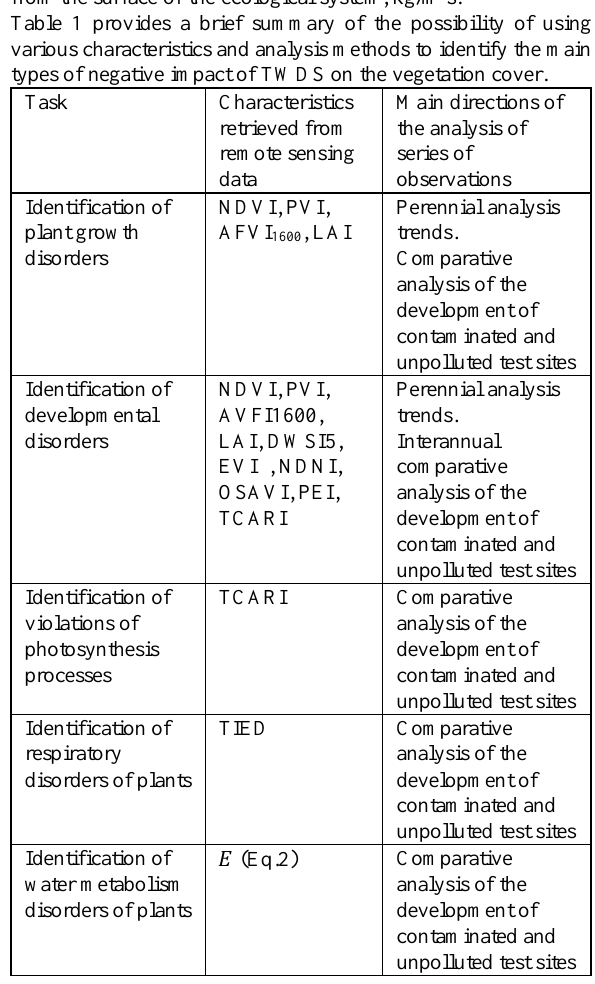
Table 1. Possibilities of identifying the main types of